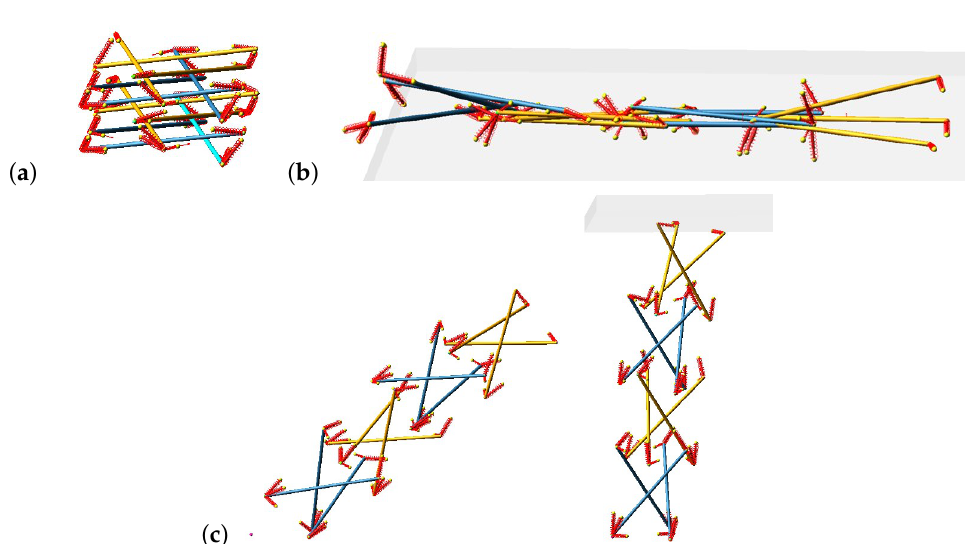
Figure 10. The overlapped simplex column deployment: ( a ) The first deployment scheme. ( b ) The second deployment scheme. ( c ) Time frames for the second deployment